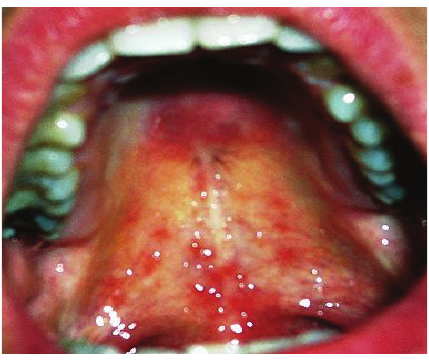
Figure 6: Healing of